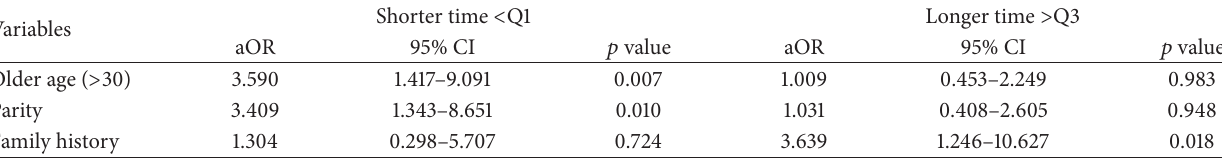
Table 4: Nontechnical predictors of shorter and longer duration of laparoscopic surgery for ovarian endometrioma.